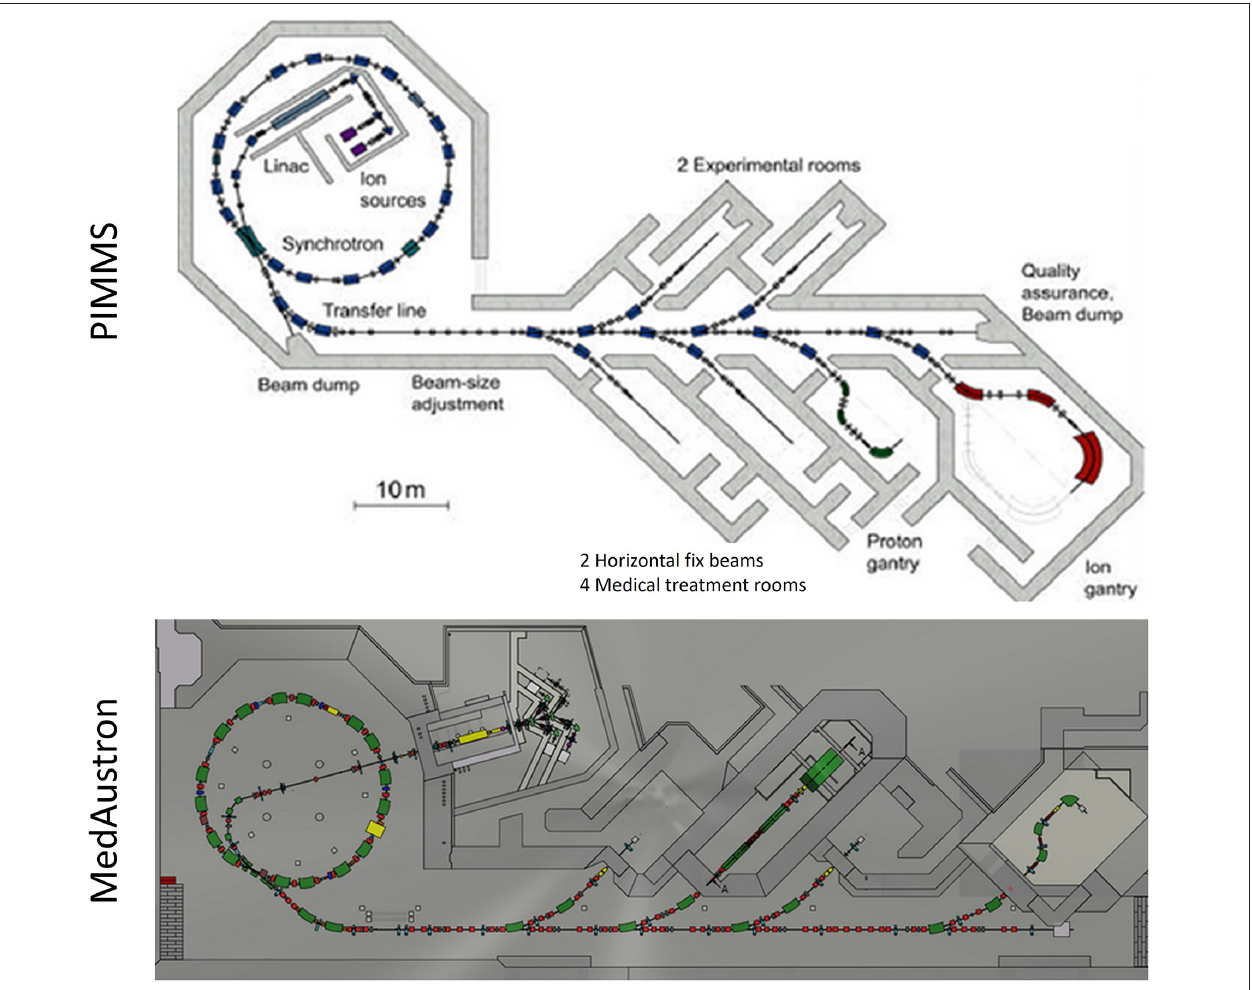
FIGURE 13 | Top : A potential layout of a carbon/proton treatment facility as proposed in the PIMMS study. Bottom : Actual MedAustron facility layout: a separated injector hall which houses 3 ECR ion source and potentially 5 source branches, completely enclosed Linac bunker for RFQ and IH-Tank, Synchrotron hall and the long extraction line which distributes the beam to Irradiation Rooms